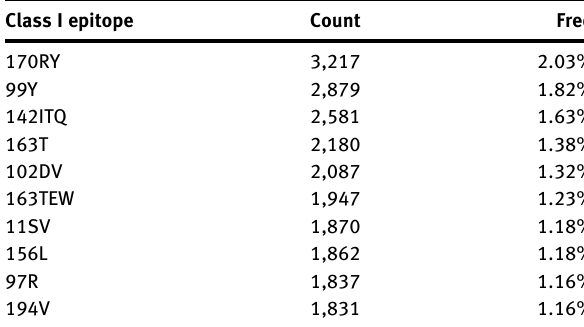
Table  : Class I epitope frequencies.